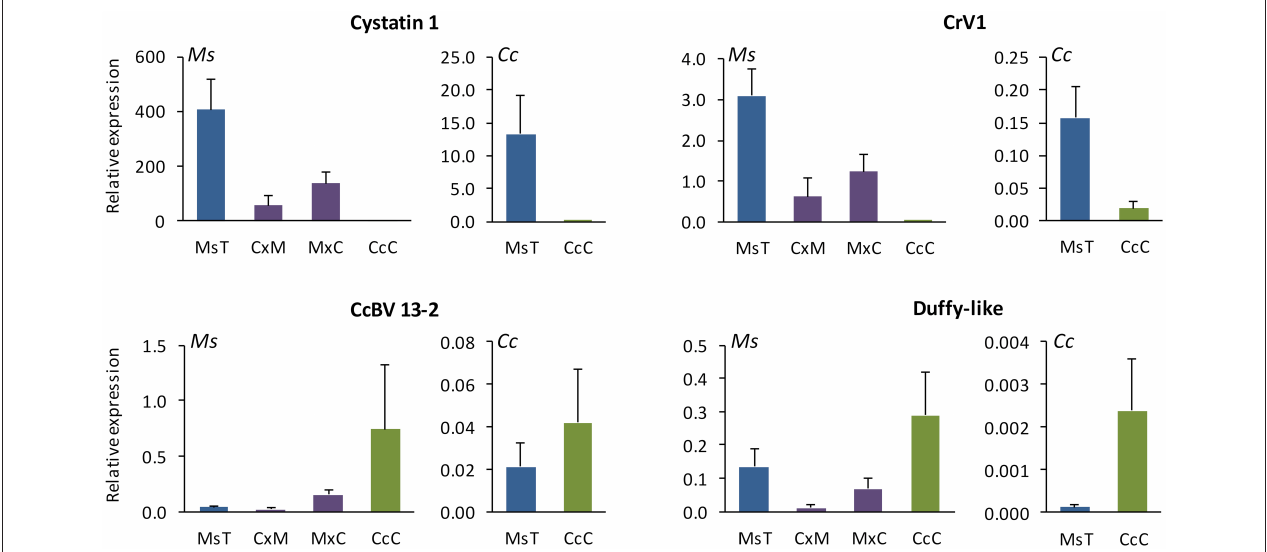
FIGURE 4 | Relative expression in vivo (mean ± SE; N = 14 for CxM hybrid and N = 8 for all other groups) of four virulent bracovirus (BV) genes that differ in hosts Manduca sexta ( Ms ; left plot for each gene) and Ceratomia catalpae ( Cc ; right plot for each gene) parasitized by two incipient species of Cotesia congregata [MsT = M. sexta on tobacco (blue) and CcC = C. catalpae on catalpa (green) and their hybrids (C × M = CcC ♂ xMsT ♀ and MxC = MsT ♂ xCcC ♀ (purple)] on M. sexta . Note that Cystatin 1 and CrV1 had low or absent expression in hosts parasitized by CcC wasps. CcBV 13-2 and Duffy-like genes from CcC wasps were highly expressed relative to those from MsT wasps, depending on the host species parasitized. All seven genes from CcC ♂ xMsT ♀ hybrids had low or absent expression in 12/14 samples; gene expression in two samples was similar to that for MsT ♂ xCcC ♀ samples. Relative expression of three other BV genes, Ankyrin 4, CcPTP-L, and CcV3-like, did not differ significantly between MsT and CcC parental